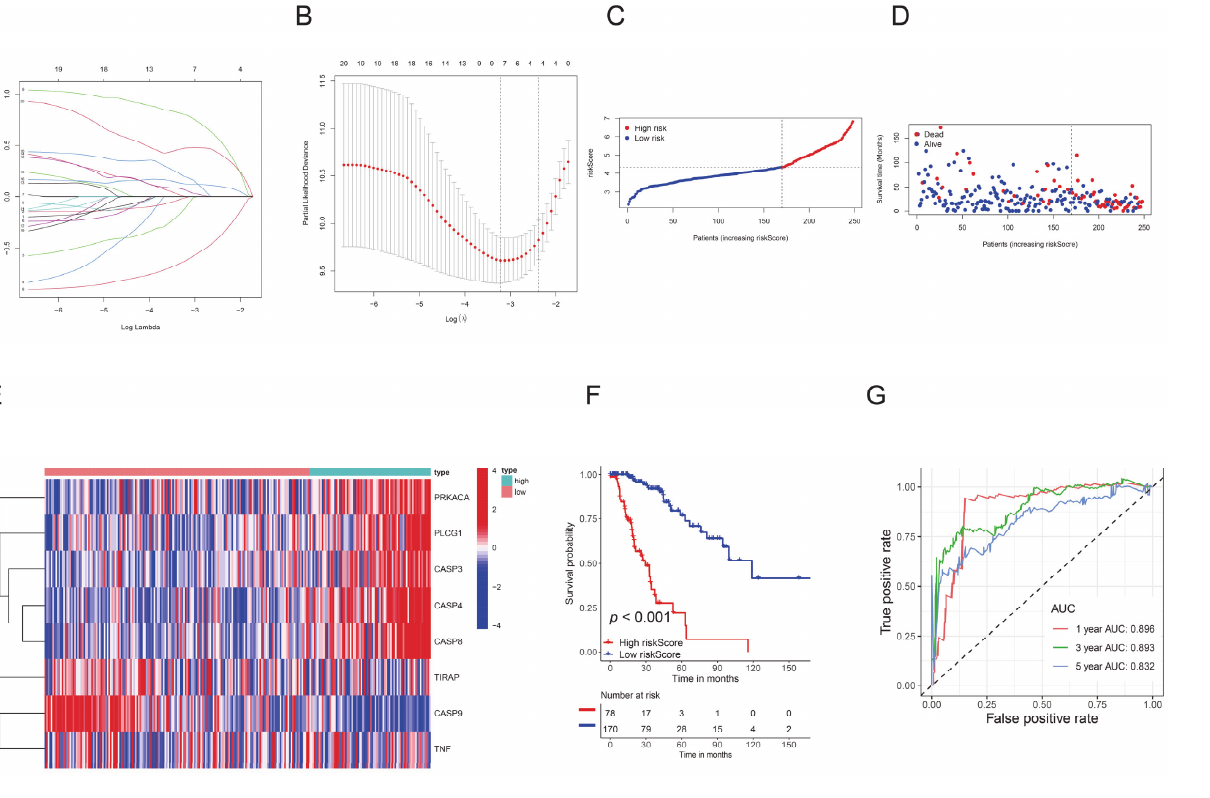
Figure 3. Development of the PyroScore. ( A ) The LASSO-Cox regression model was used to identify the most robust genes. ( B ) Cross-validation of parameter selected by LASSO. ( C ) Distribution of patients according to the PyroScore. ( D ) Survival status distribution of different risk patients. ( E ) Heatmap showing expression levels of 8 PRGs among two risk groups. ( F ) Overall survival difference among the two risk groups. ( G ) ROC curves measure the predictive value of PyroScore. We also performed a subgroup survival analysis based on 2021 WHO classification [28]. The subgroup analysis demonstrated the predictive value of pyroscore in astrocytoma, oligodendroglioma, and IDH-wt patients (Figure